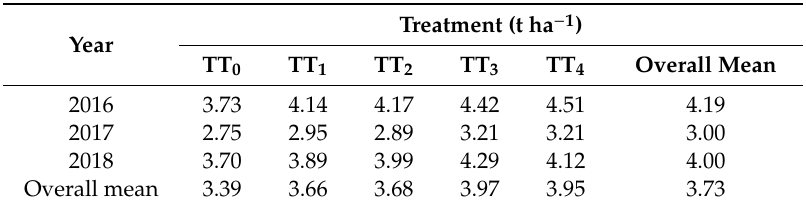
Table 6. Mean corn yields from all three years of the research, depending on the liquid fertilizer treatment (TT 0 –TT 4 ).